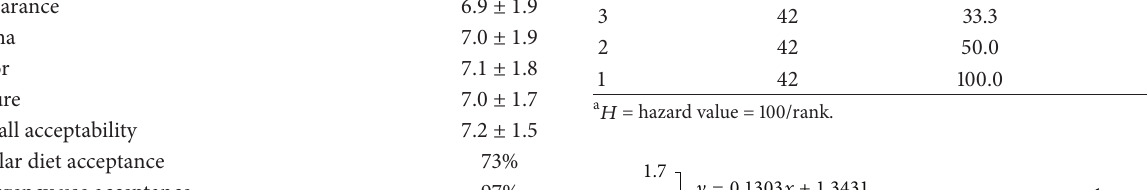
Table 7: Mean hedonic scores and percent acceptance from Fijian cultural acceptability sensory panel for dehydrated taro slices a .